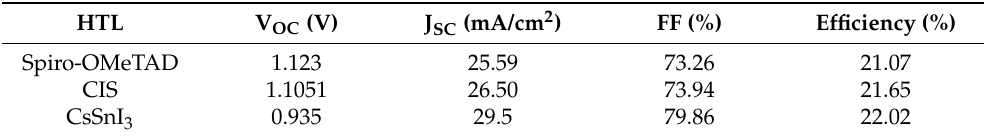
Table 4. The effect of HTL on the solar cell parameters. HTL V OC (V) J SC (mA/cm 2 ) FF (%)